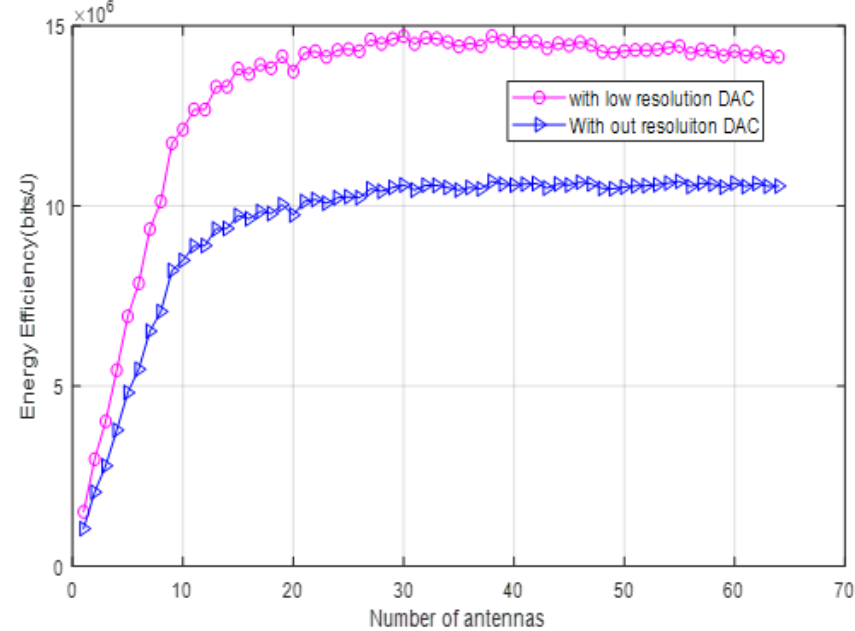
Figure 5. Energy efficiency as a function of the number of BS antennas when the number of terminals k =